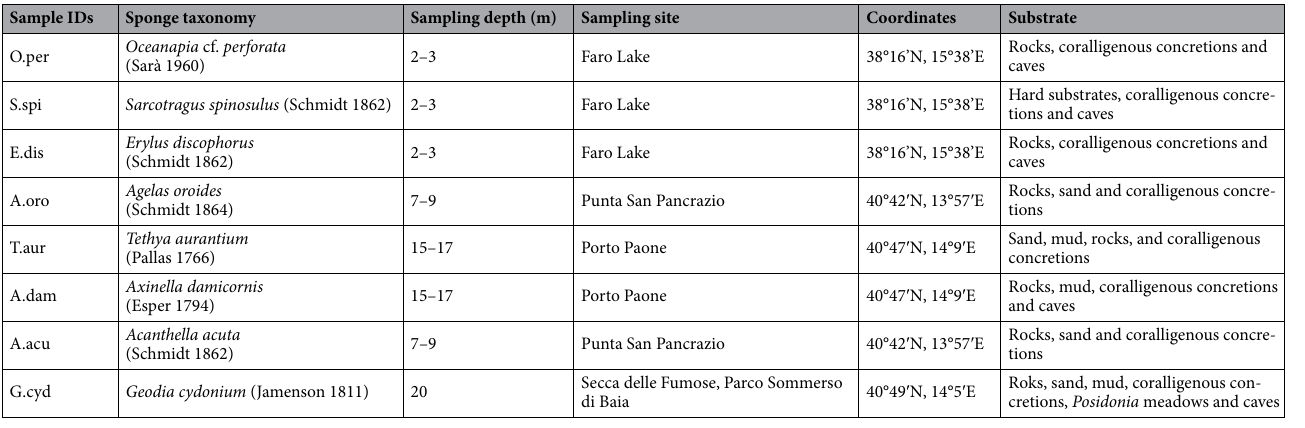
Table 1. Sample IDs, taxonomy, sampling depth (m) and sites, geographical coordinates and type of